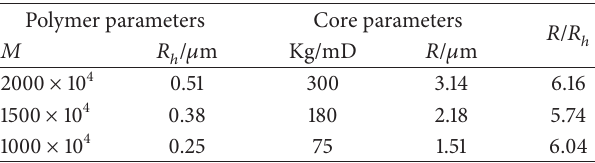
Table 4: Calculation results of the specific value of pore throat radius median to average hydrodynamic